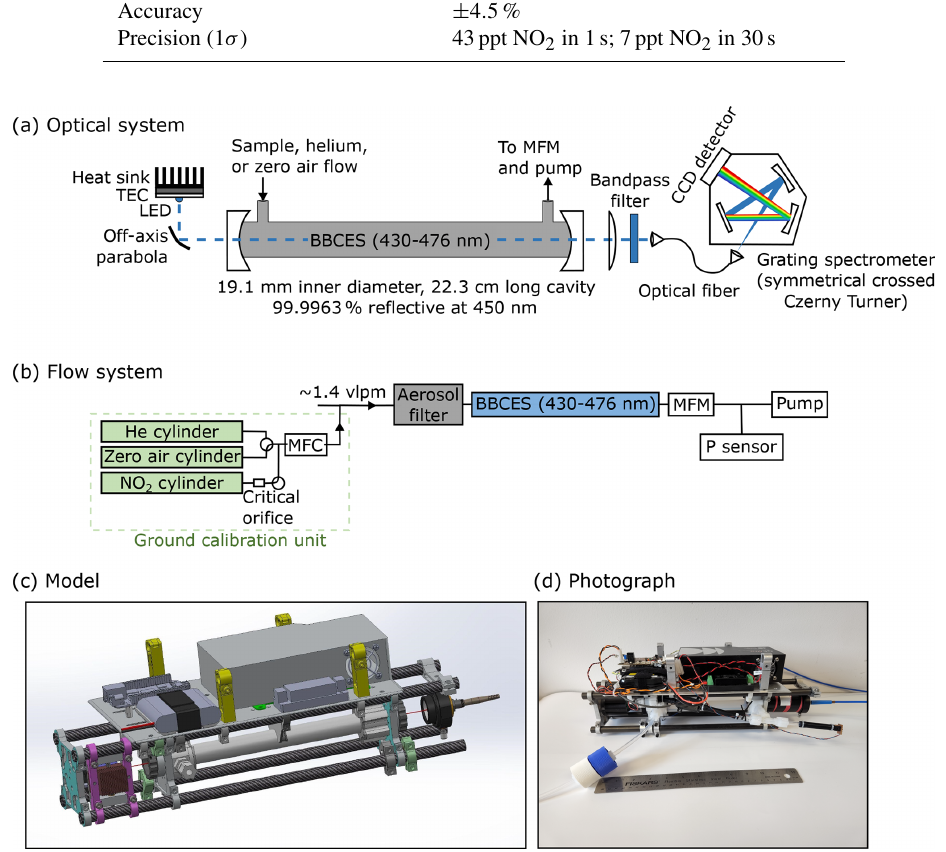
Figure 1. (a) Schematic of the optical system, showing the LED, off-axis parabolic mirror, optical cavity, and spectrometer. (b) Block diagram of the flow system, showing the ground calibration unit, inlet filter, sample cell, mass flow meter (MFM), pressure sensor, and pump. (c) Model of the instrument, with quick-release clamps for mounting the instrument onto the drone highlighted in yellow. (d) Photograph of the instrument. The total dimensions of the instrument are approximately 45 × 20 × 20cm (length × width ×